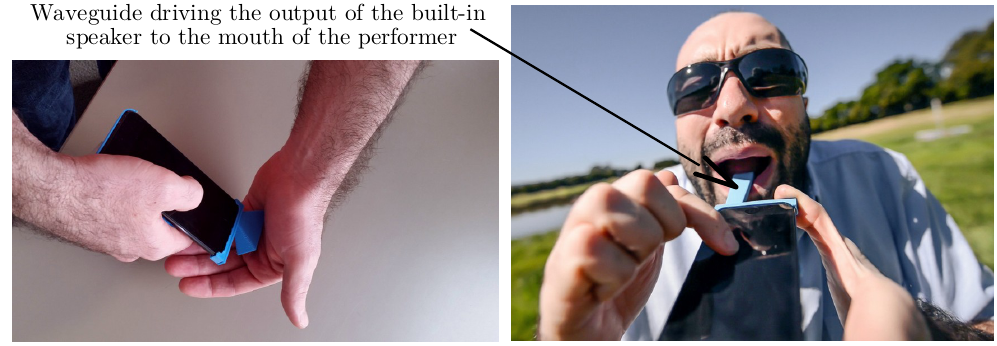
Figure 6. Hand resonator ( on the left ) and mouth resonator ( on the right ) for mobile device built-in